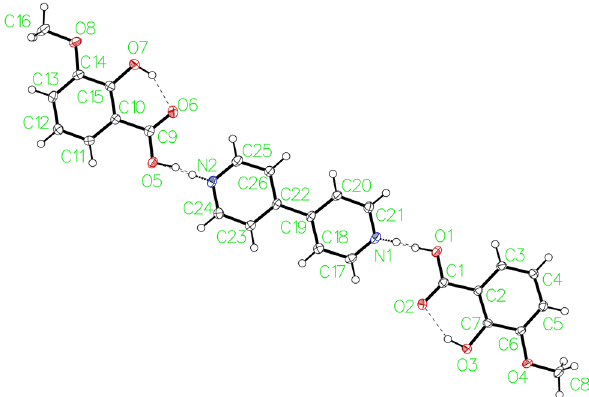
Table  : Data collection and